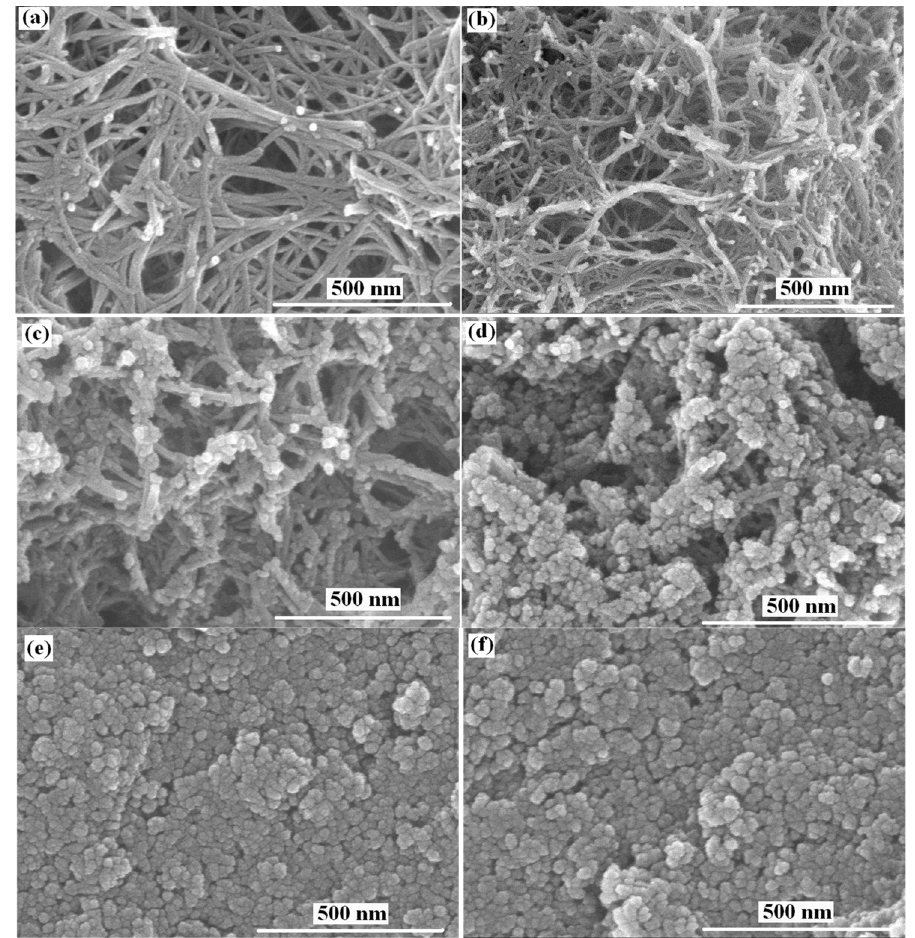
Figure 3. TEM of acid treated nanotubes showing the non-seamless open ends and multiwalled morphology.